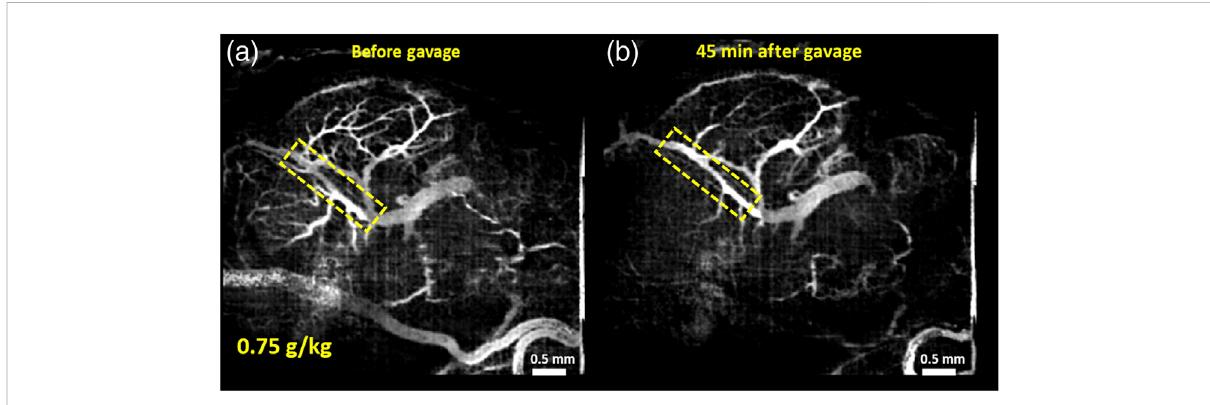
FIGURE 5 Maximum intensityprojection(MIP)ofcorrelationmappingopticalcoherenceangiography(cm-OCA) ofmurinefetalbrainvasculature. (A) MIP cm-OCAoffetalbrainvasculaturebeforematernalexposuretoethanol. (B) MIPcm-OCAoffetalbrainvasculature45 minaftermaternalexposureto ethanol at a dose of 0.75 g/kg showing acute vasoconstriction. The dashed rectangle shows the main branch of the vessel on which quanti fi cations were performed demonstrating the effect of ethanol. Reproduced from (Raghunathan et al.,